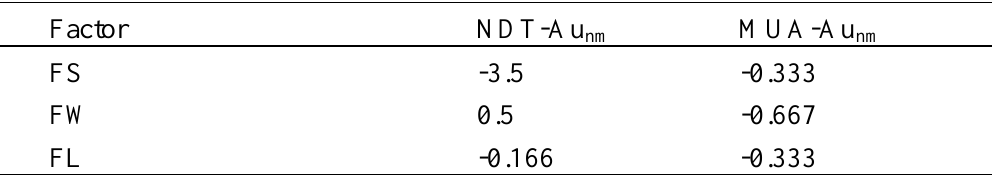
Table 6. Effect of the microelectrode design parameters (factors) on device performance for two the different nanostructured thin